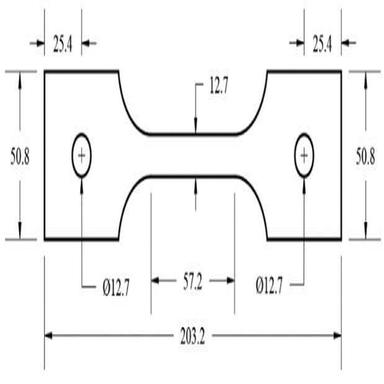
Dimension of specimen (in mm).